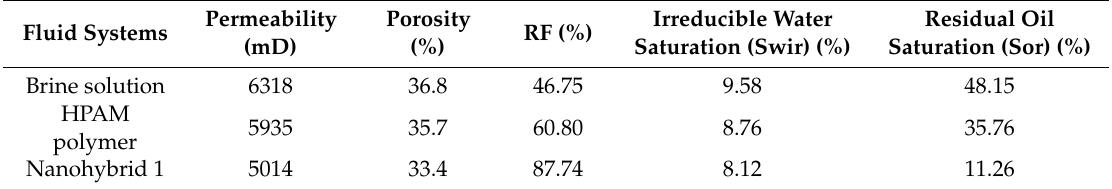
Table 5. Properties of the sandpack and oil recovery parameters for di ff erent flooding experiments.